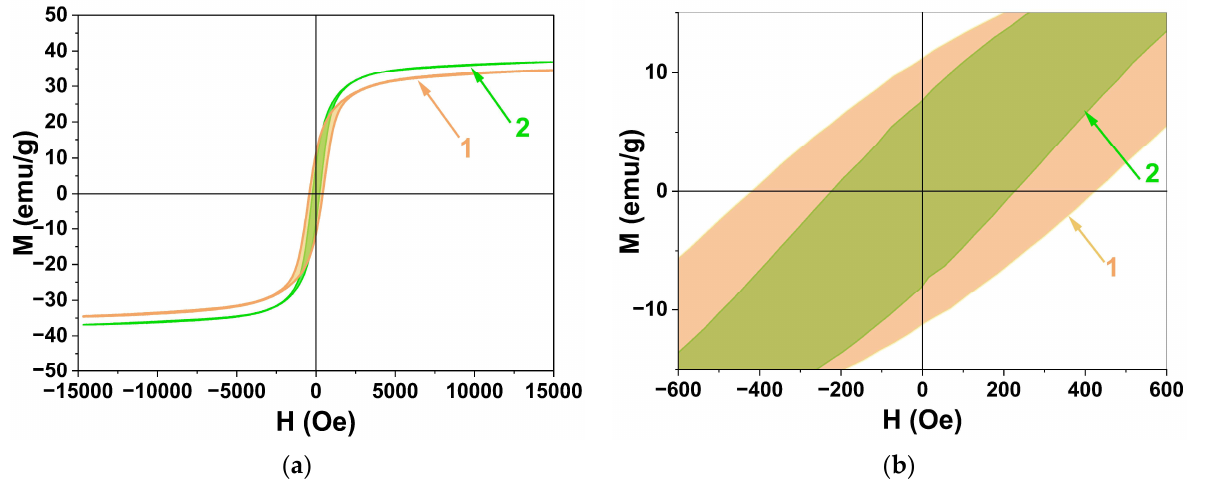
Figure 9. The magnetization curves ( a ) and their partial enlarged detail ( b ) measured in magnetic field H = ±15 kOe at 298 K: 1—without the use of polysaccharides and 2—using dextran-40. Table 5. Magnetic parameters obtained from the results of magnetic hysteresis loops in Figure 9.